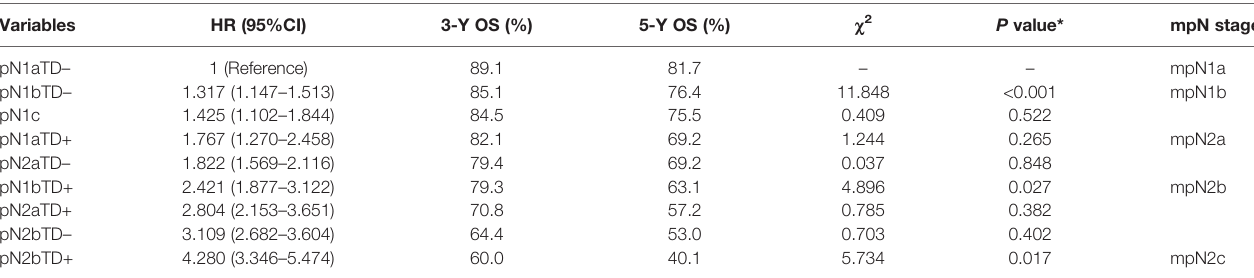
TABLE 4 | Modi fi ed pN stage in the training